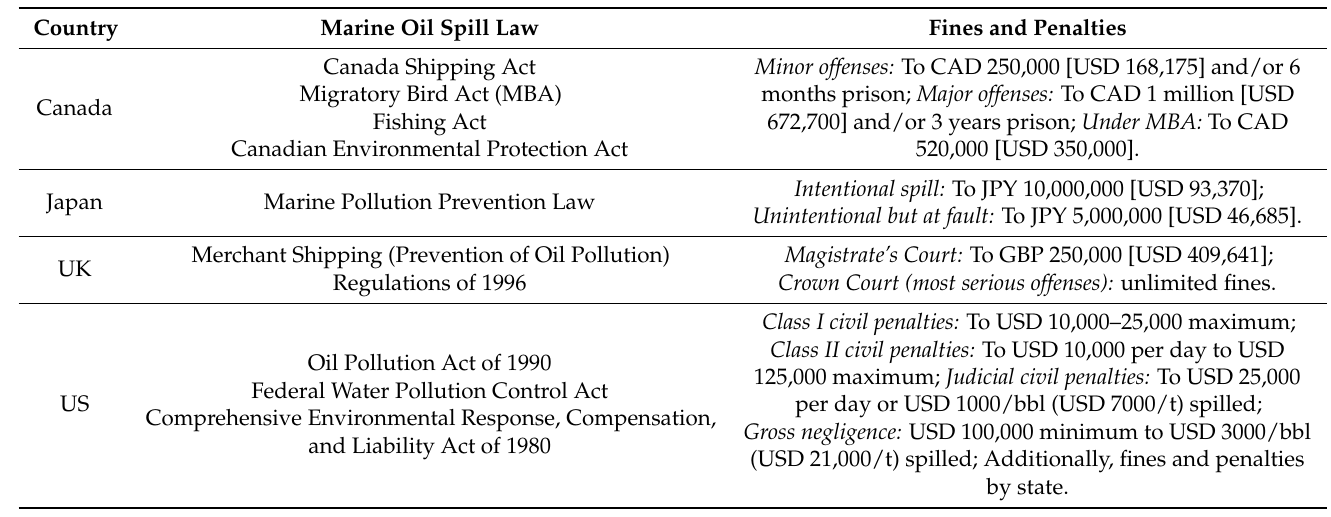
Table 1. Marine oil spill fines and penalties